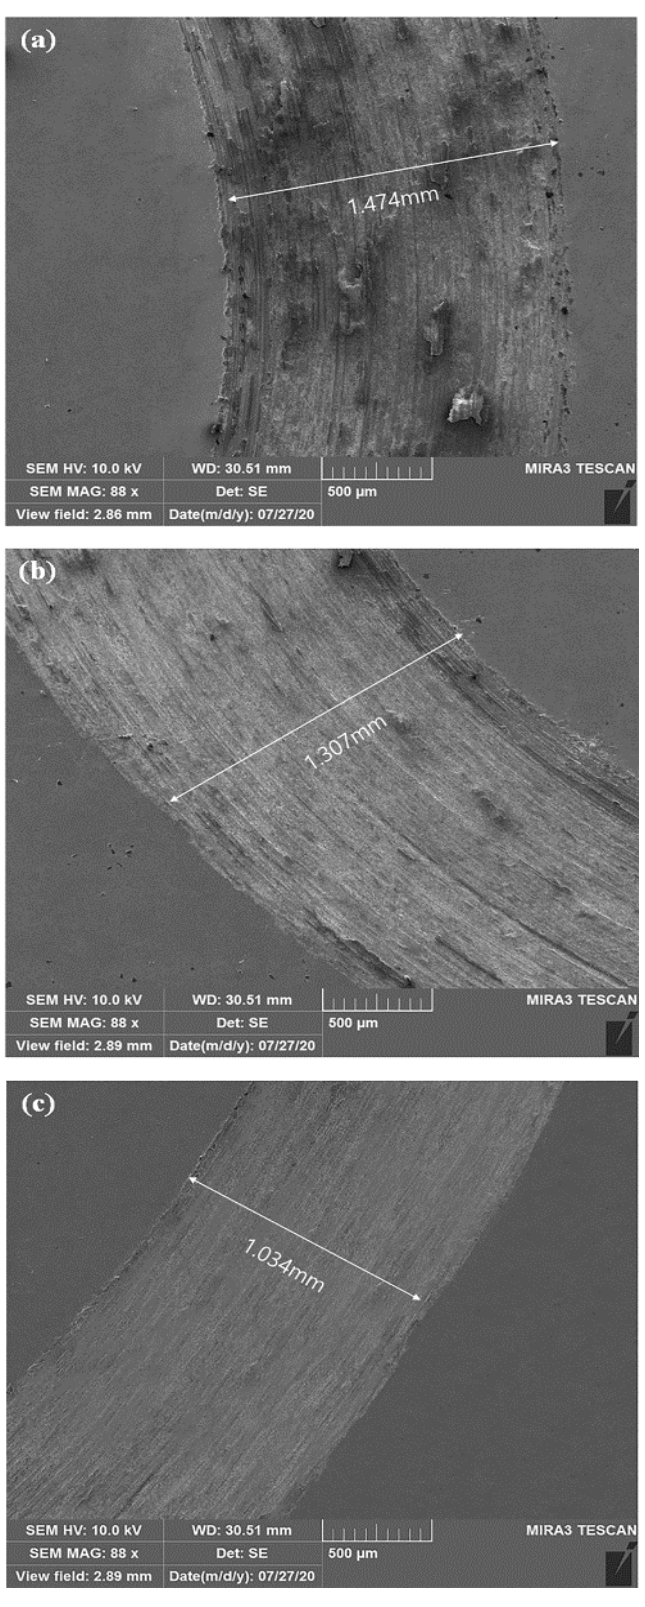
Figure 7. Wear track images ( a ) as-deposited TiZrN coating, ( b ) carbon-doped TiZrN coating (20% laser output), ( c ) carbon-doped TiZrN coating (40% laser output).